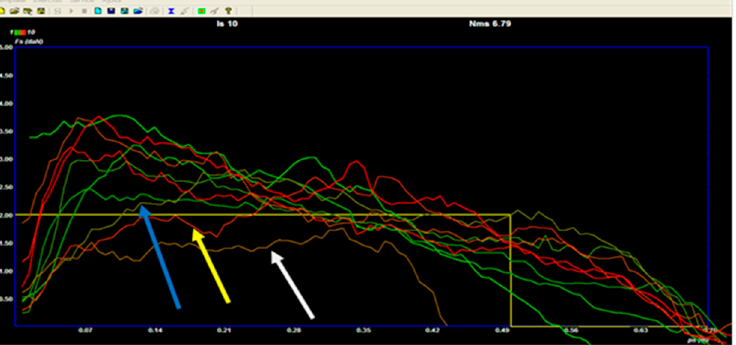
Figure 3. The visual–psychomotor scheme made without visual stimulus, Subject L. M. Thus, subjects achieved 20 tractions, helmet type, assisted by ERGOSIM, on a given model. From the number of executions, 10 of these were executed without looking at the